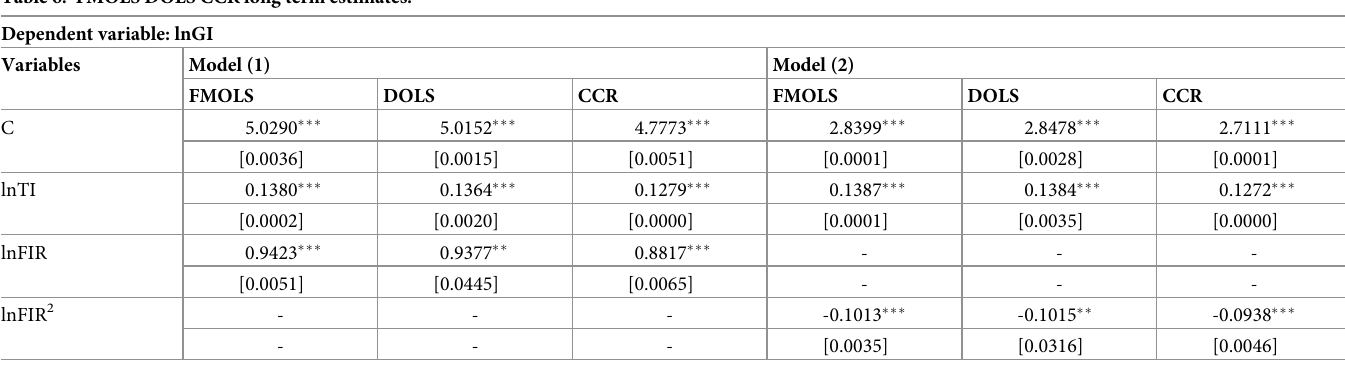
Table 6. FMOLS DOLS CCR long term